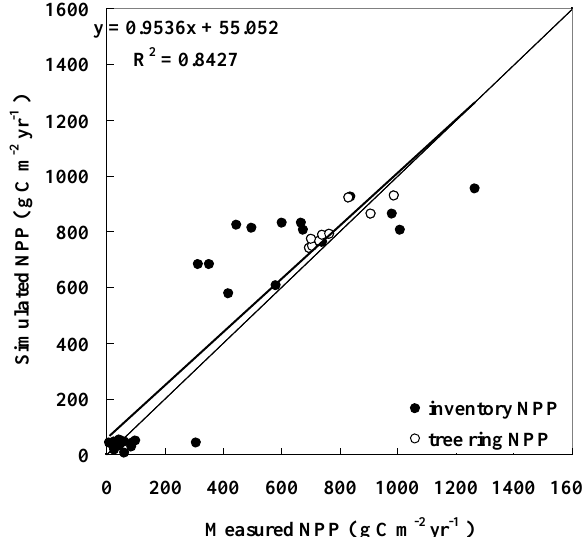
Figure 4. Simulated NPP using BEPS-TerrainLab in comparison with NPP calculated 2 Fig. 4. Simulated NPP using BEPS-TerrainLab in comparison with NPP calculated from tree ring data collected in the summer of 2004. from tree ring data collected in the summer of 2004. The solid line is the 1:1 line. 3 The solid line is the 1 : 1